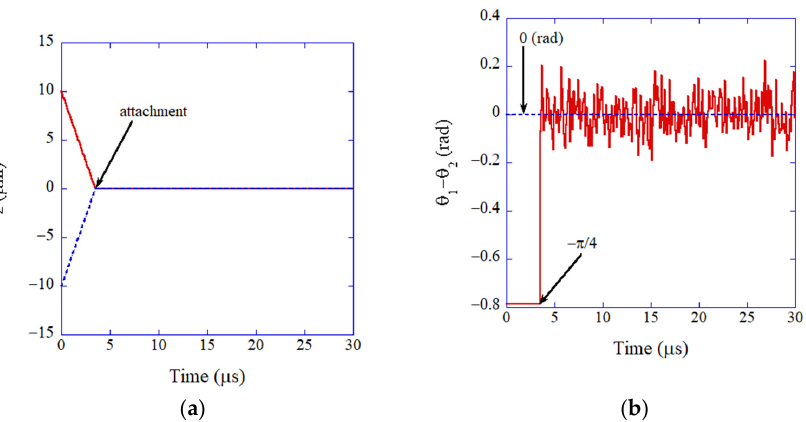
Figure 7. The results of numerical simulation of the ODE model for oriented attachment of BaTiO 3 nanocrystals (5 nm) in organic solvent (mesitylene) as a function of time ( a ) The position of nanocrystals. ( b ) The relative angle of the electric dipoles. Reprinted with permission from Ref. [85]. Copyright 2015, the American Chemical Society.